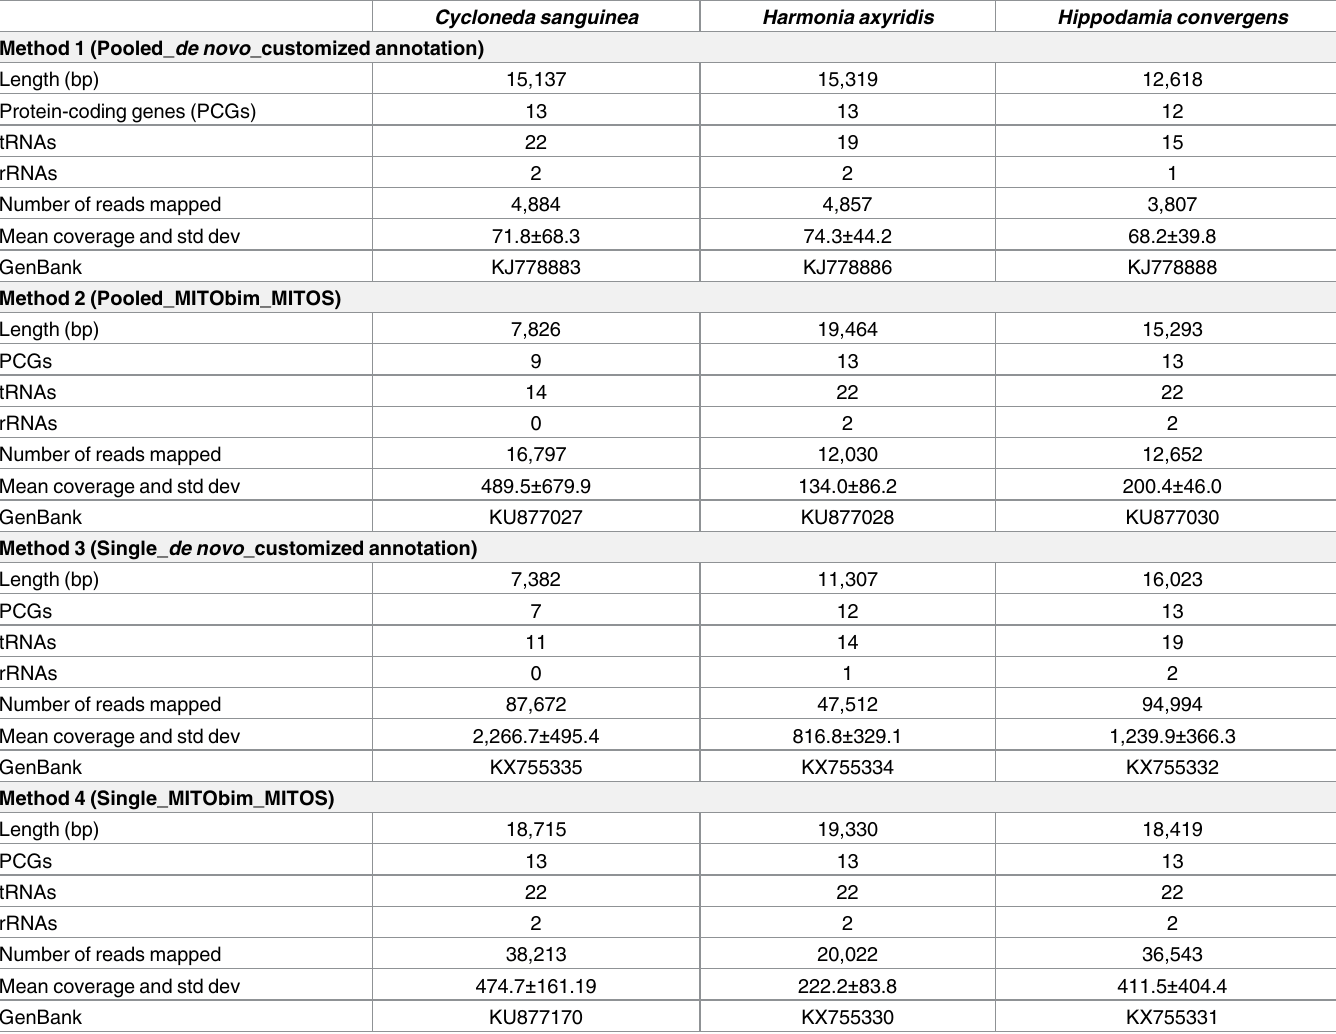
Table 2. Coccinellid mitogenomes obtained using different